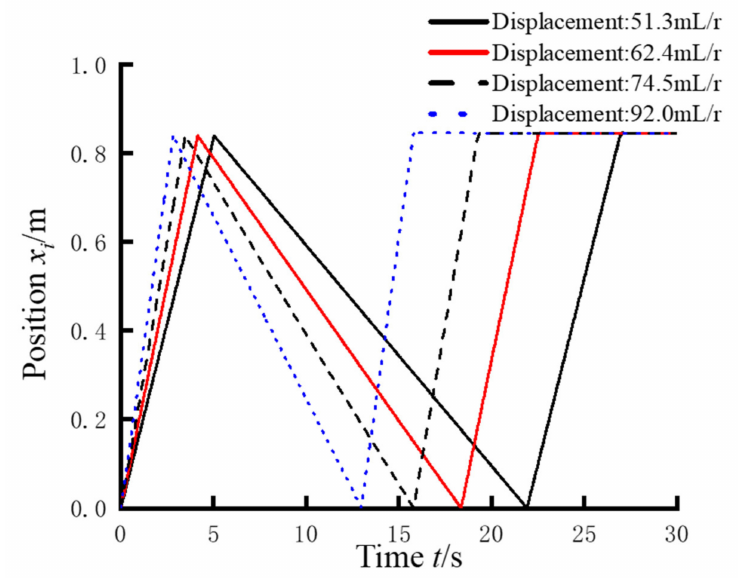
Figure 12. Load position with different displacement of